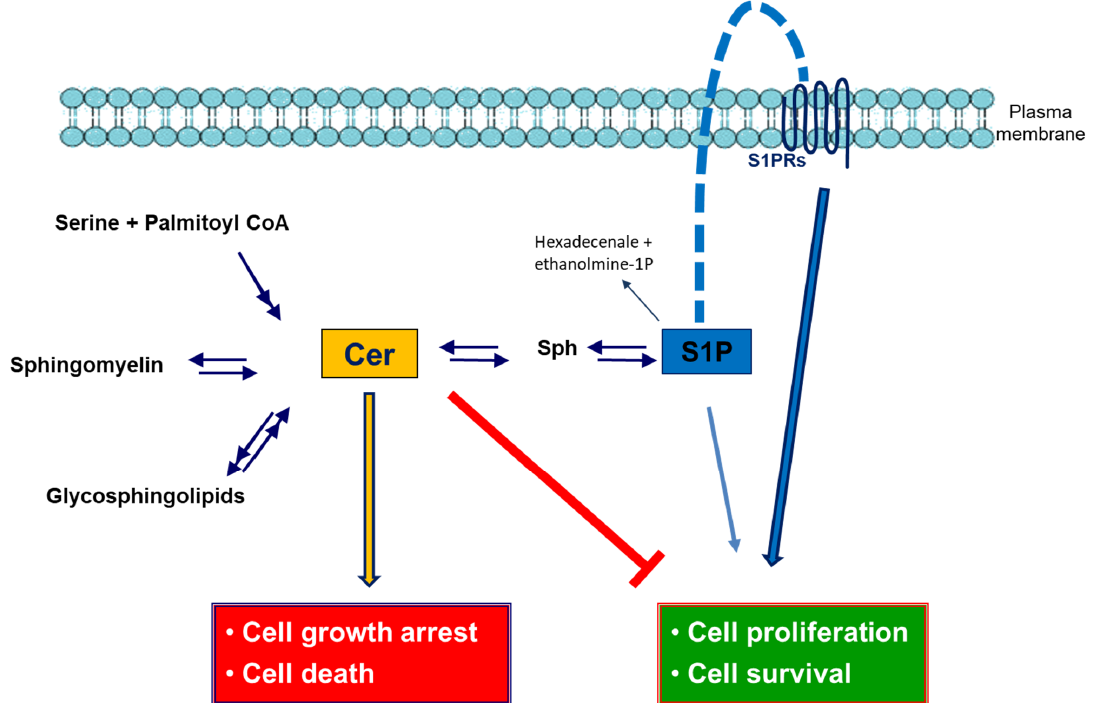
Figure 1. Ceramide and sphingosine-1-phospate metabolism and signaling in CNS. Ceramide (Cer) is generated from serine and palmitoyl Coenzyme A (de novo pathway) and through the acylation of sphingosine (Sph) (salvage pathway) at the endoplasmic reticulum. Cer is a substrate for sphin- gomyelin (SM) and glycosphingolipids synthesis at the Golgi apparatus. Sphingosine 1-phosphate (S1P) is synthesized via phosphorylation of sphingosine (Sph). S1P can be dephosphorylated back to Sph and then reacylated to Cer, or it can be degraded to hexadecenal and